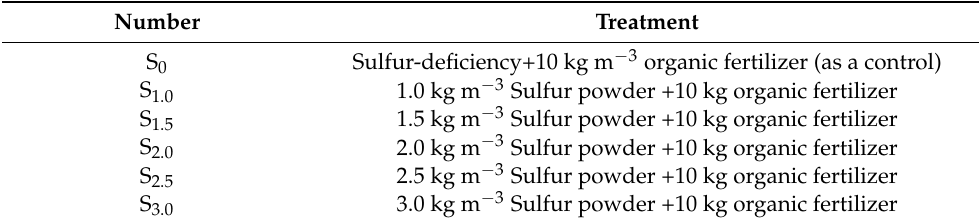
Table 1. The concentration of sulfur treatment used in this